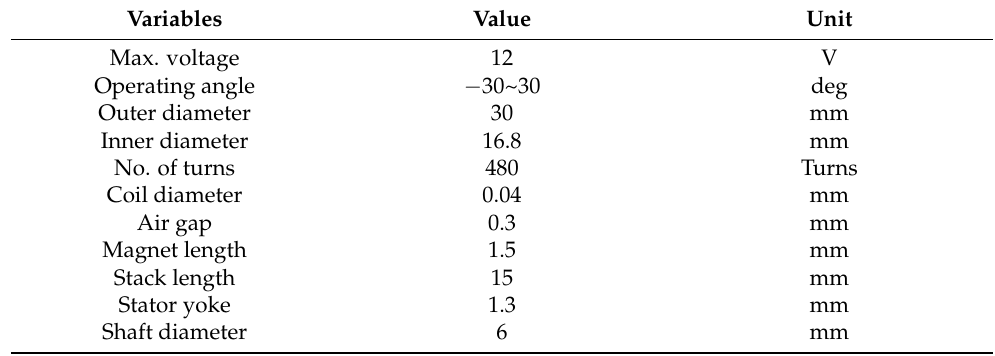
Table 1. SPMSM specifications for tilting motors.